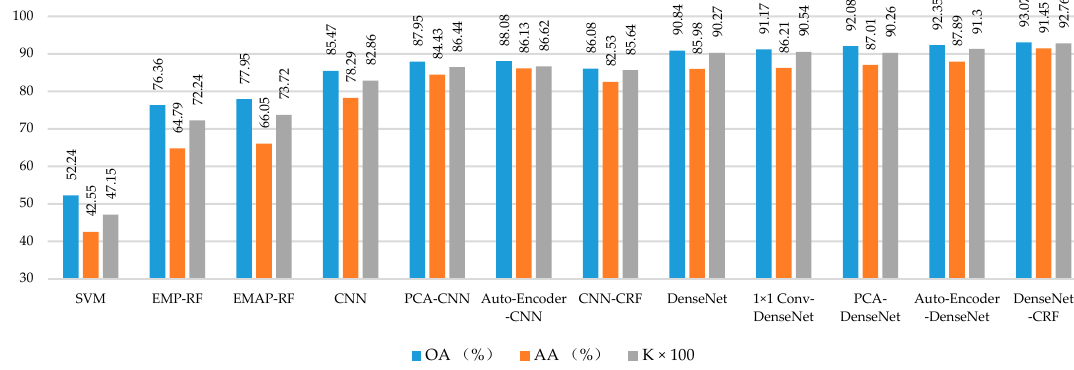
Figure 5. Test accuracy of different supervised methods on the Indian Pines dataset.